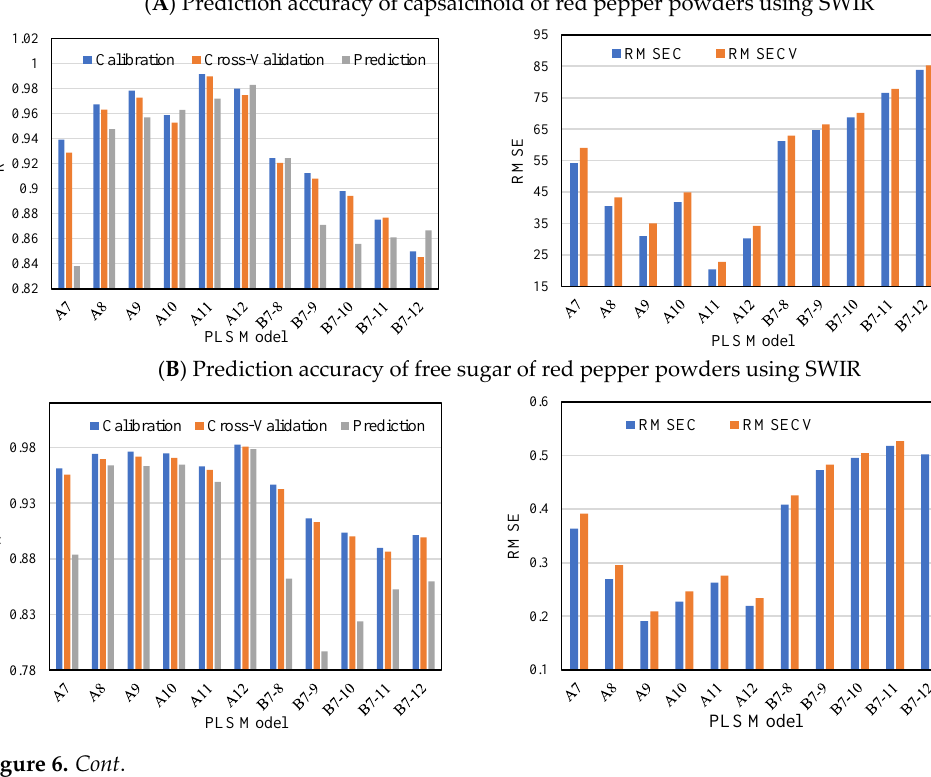
Figure 5. Prediction accuracy of capsaicinoid ( A ), free sugar ( B ) and ASTA color ( C ) of red pepper powders using VIS-NIR wavelength range in accordance with moisture content. RMSEC, root mean square error of calibration; RMSECV, root mean square error of cross-validation. ( A ) Prediction accuracy of capsaicinoid of red pepper powders using SWIR